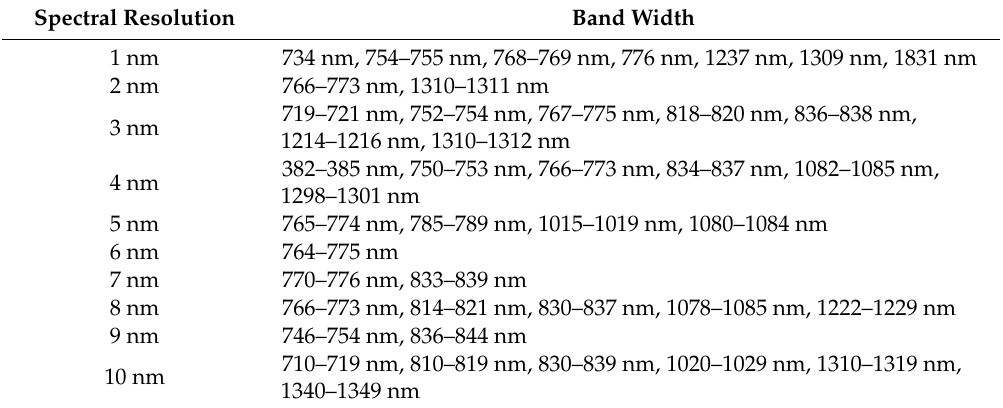
Table 4. Spectral location of the Cd pollution feature bands for any resolution.